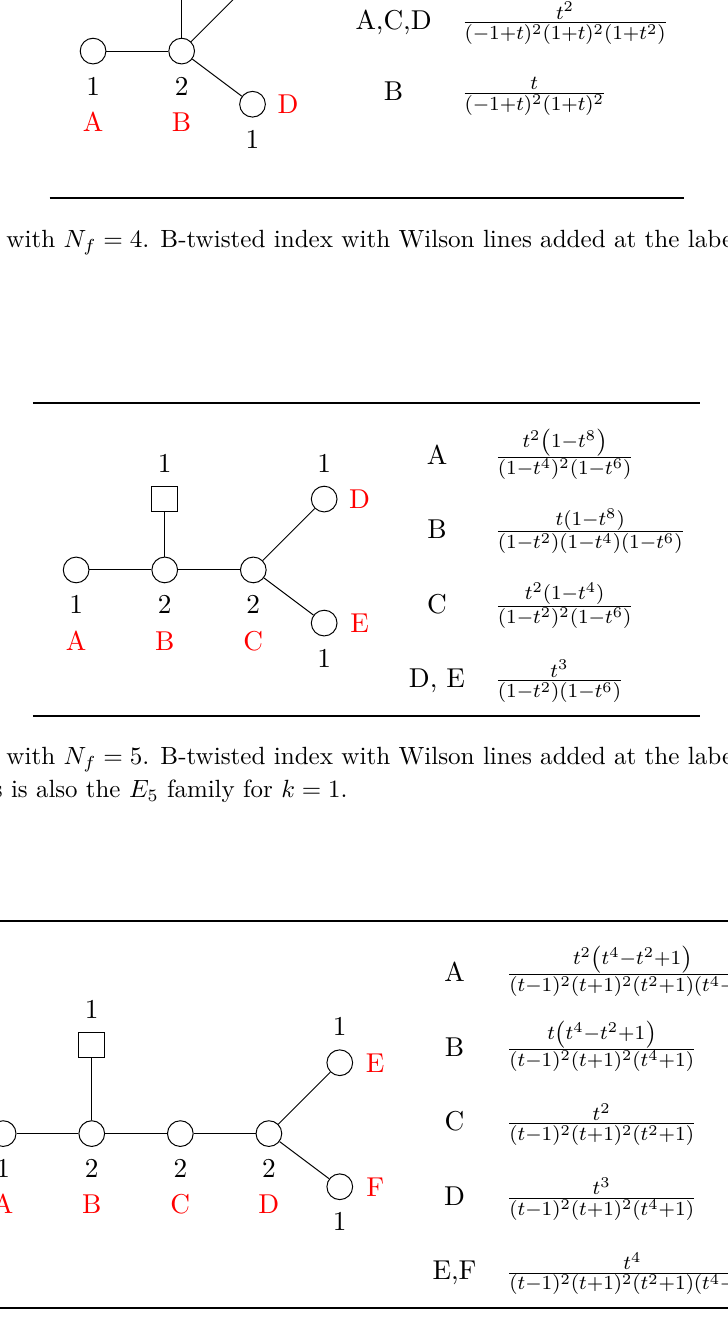
Table 8. Sp(1) with N f = 6 . B-twisted index with Wilson lines added at the labelled position in the